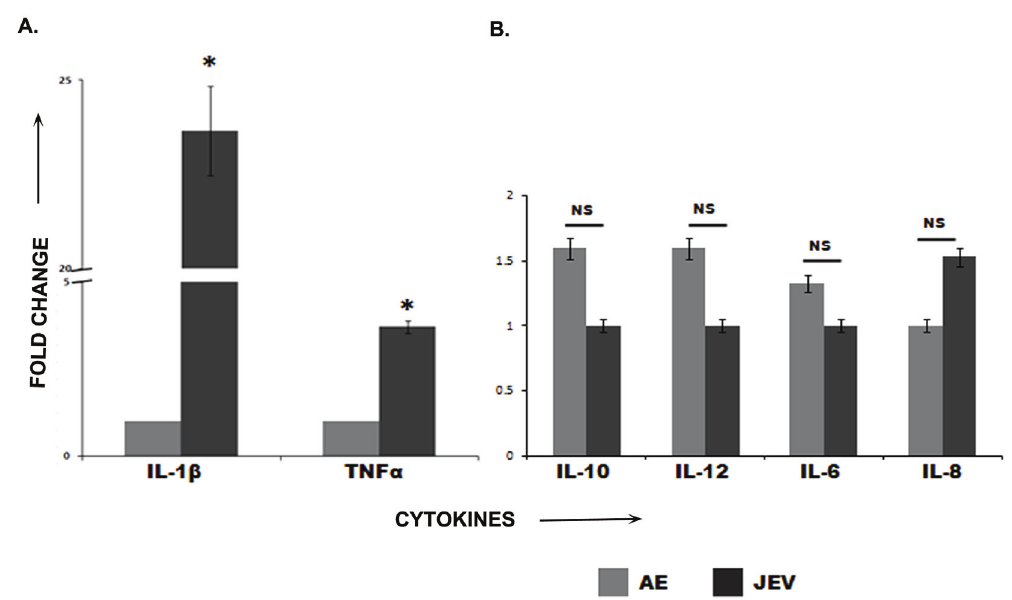
Figure 2. (A and B). Inflammatory cytokine profile of cerebrospinal fluid from AES and JEV patients. IL-8, IL-1 β , IL-6, IL-10, TNF α , and IL-12 concentrations were measured by flow cytometry using Human Inflammatory Cytokine Kit (BD Biosciences, San Diego, CA, USA) as per manufacturer’s instructions. Elevated levels of IL-1 β and TNF α were observed in the JE samples ( 2A ) whereas no significant changes were observed in the rest ( 2B ). The image is a representative of 3 replicate experiments.